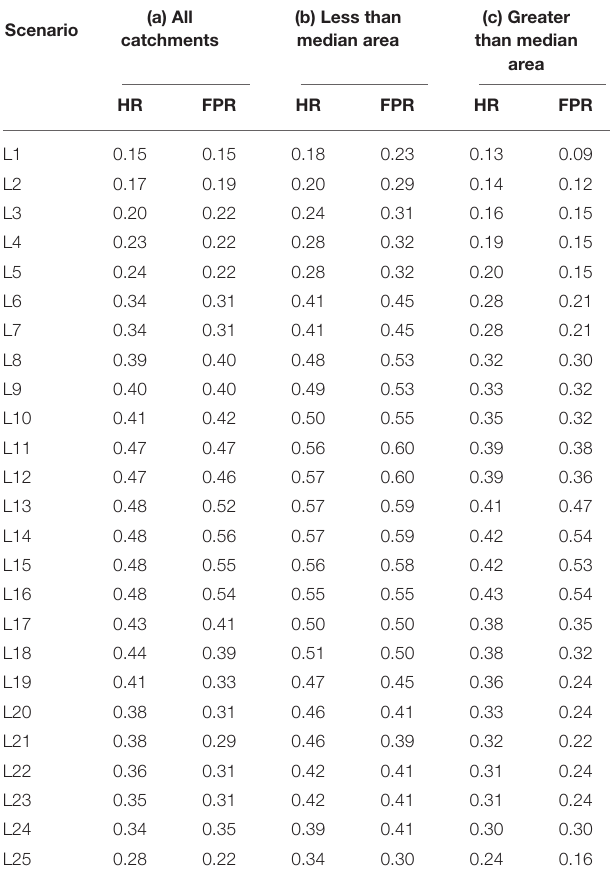
TABLE 2 | The comparison of hit rates (HR) and false positive rates (FPR) for 25 hurricane scenarios.